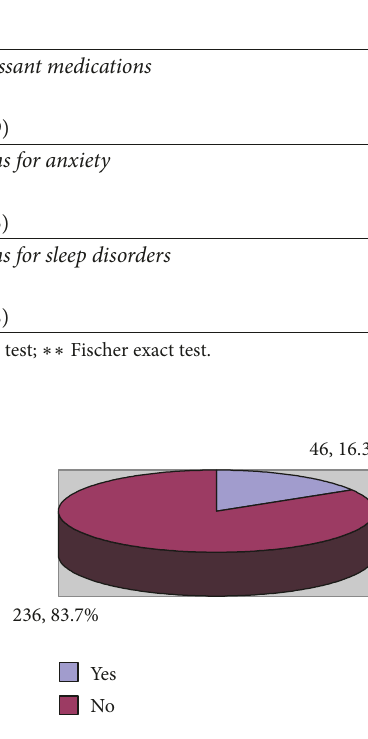
Figure 6: Prevalence of burnout among emergency department physicians and